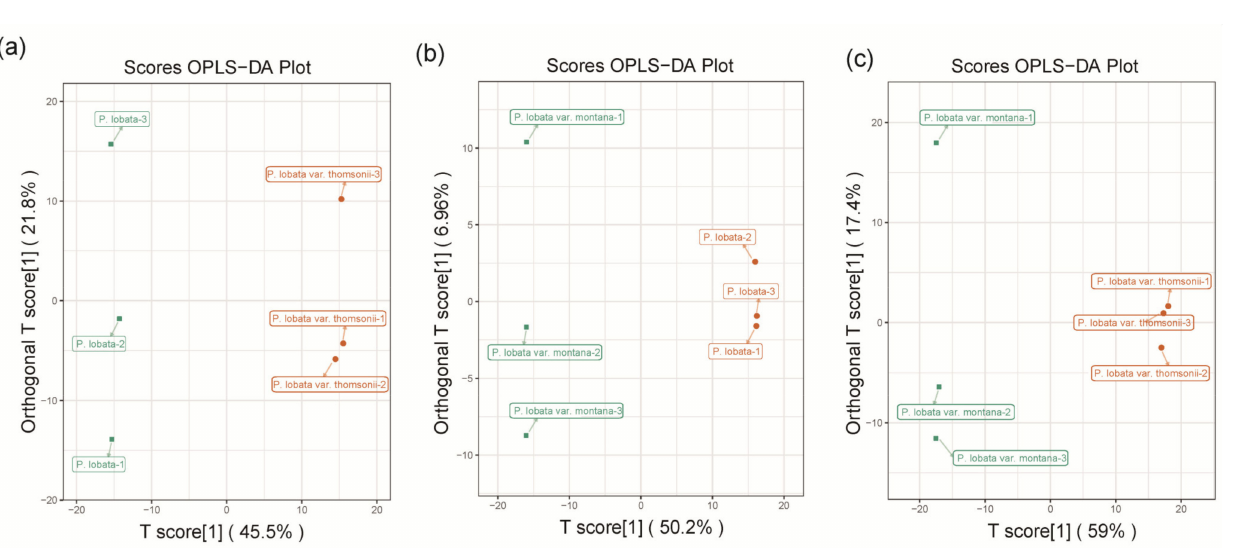
Figure 3. OPLS-DA of metabolites identified among P. lobata , P. lobata var. thomsonii, and P. lobata var. montana ( a – c ). OPLS-DA model plots for the comparison group P. lobata versus P. lobata var. thomsonii, P. lobata versus P. lobata var. montana, and P. lobata var. thomsonii versus P. lobata var. montana,